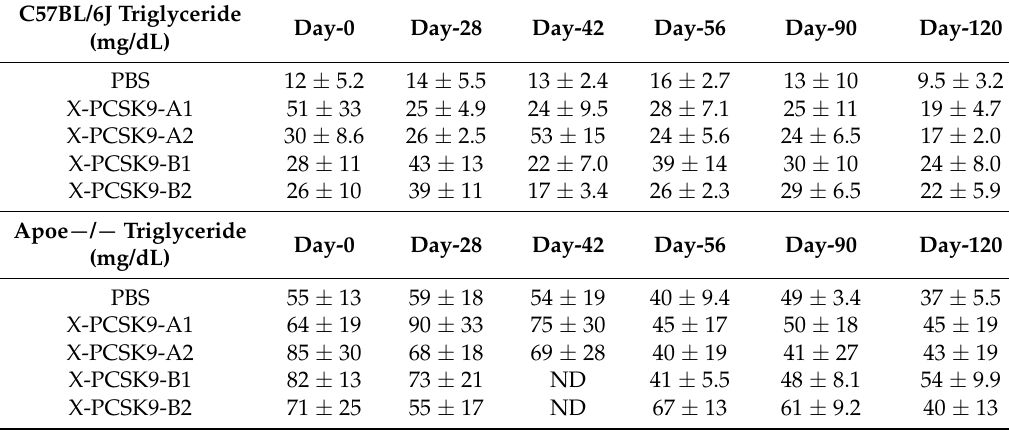
Table 4. Plasma triglyceride levels in C57BL/6J and Apoe − / − mice after X-PCSK9 isomers A1, A2, B1 and B2 immunogen treatment. Each value represents the average fasting plasma concentration of 5 mice at the indicated time. The results are expressed as mean ± S.D. ND = not determined.